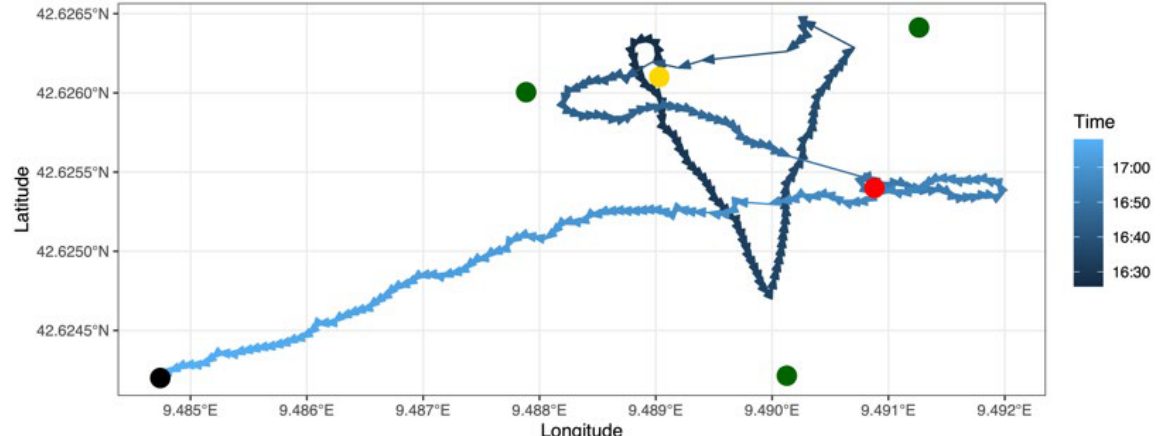
Figure 8. GPS track of the boat during the test experiment. The yellow point represents the starting point, and the black point represents the end point of the towed test. The red point represents the position from which the experiment for the determination of the maximum operational distance of our system began. Green points represent the receivers.